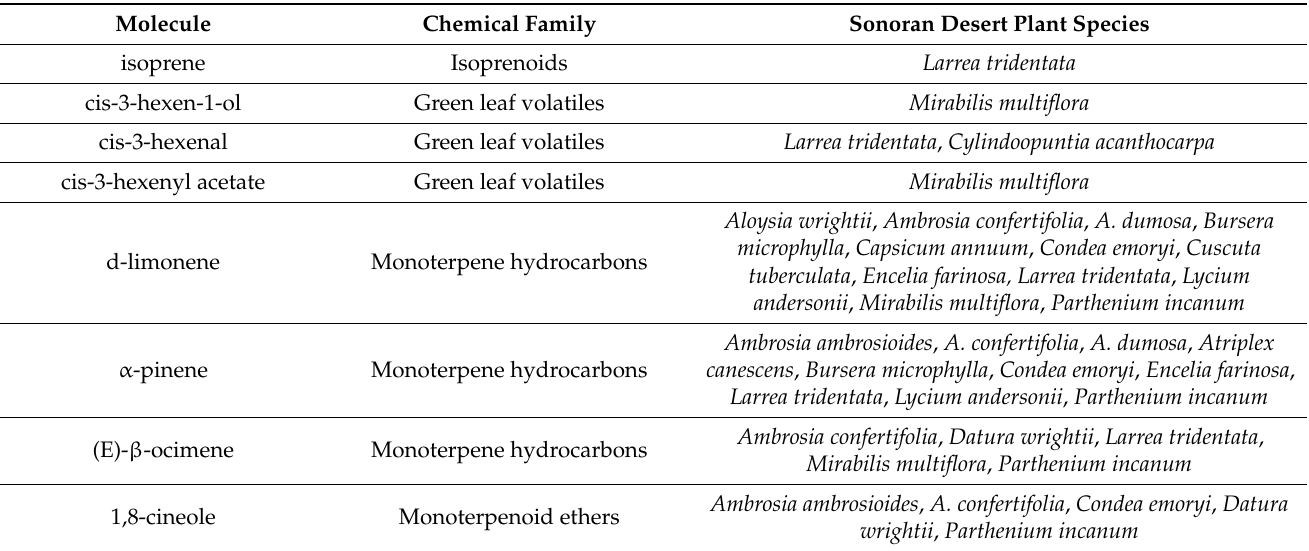
Table 3. Forest BVOCs and their chemical characteristics listed on the basis of the magnitude of emissions (in descending order, after Antonelli et al.